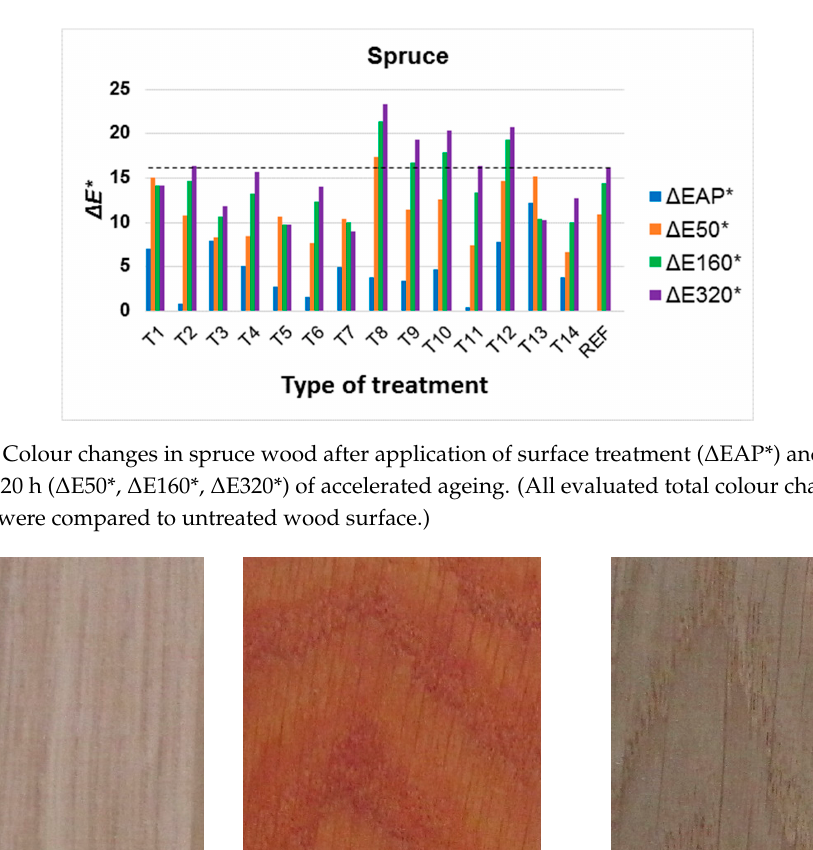
Figure 8. Photos of colour changes in oak wood ( a ) after application of surface treatment T1 with 3% concentration of nanoparticles TiO 2 ( b ); and additional colour change after 4 h of accelerated ageing